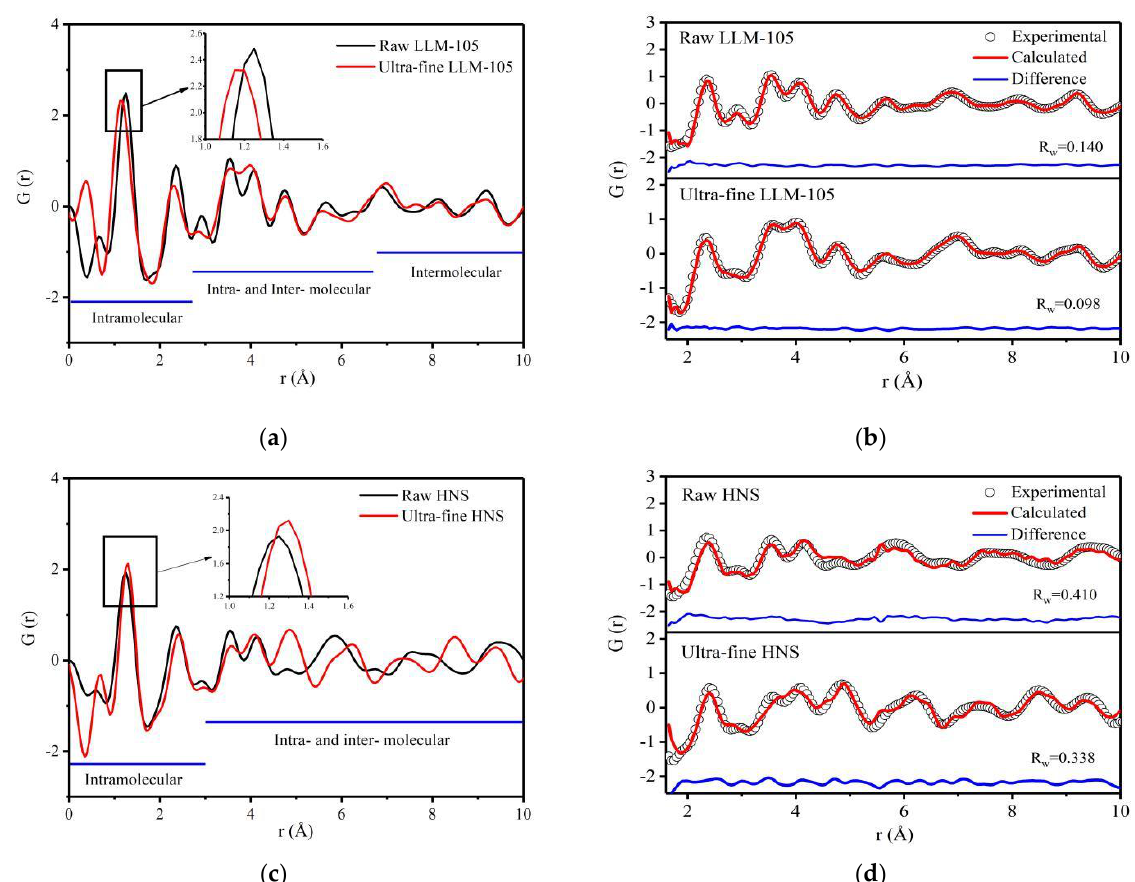
Figure 4. PDF curves and fitting results of two samples with different particle sizes: ( a ) PDF curve of LLM-105 with different particle sizes; ( b ) PDF fitting results of LLM-105; ( c ) PDF curve of HNS with different particle sizes; ( d ) PDF fitting results of HNS.